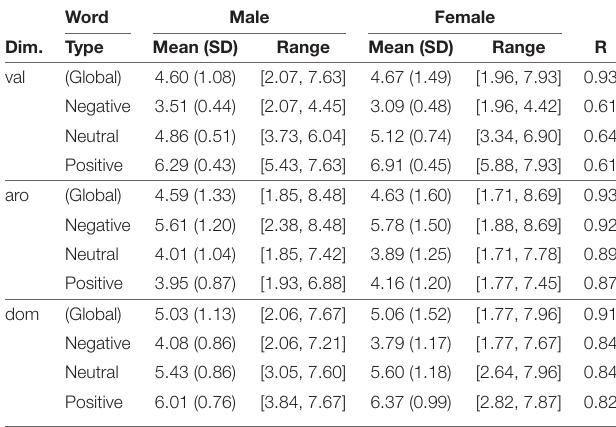
TABLE 7 | Means, standard deviations, range values, correlation indexes and differences of means of the 1,034 words ratings of the Spanish S-ANEW for females and males in the three affective dimensions, globally and per valence classification.